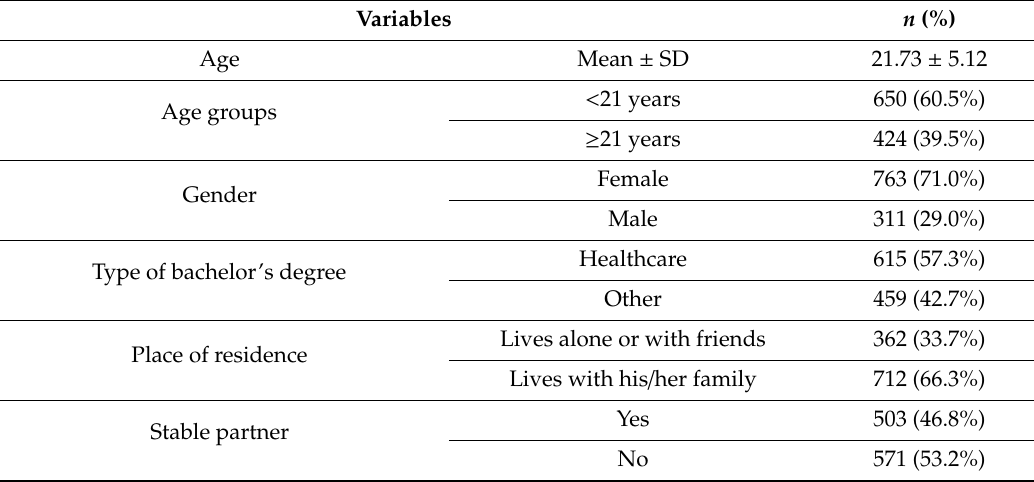
Table 1. Participants’ characteristics ( n =